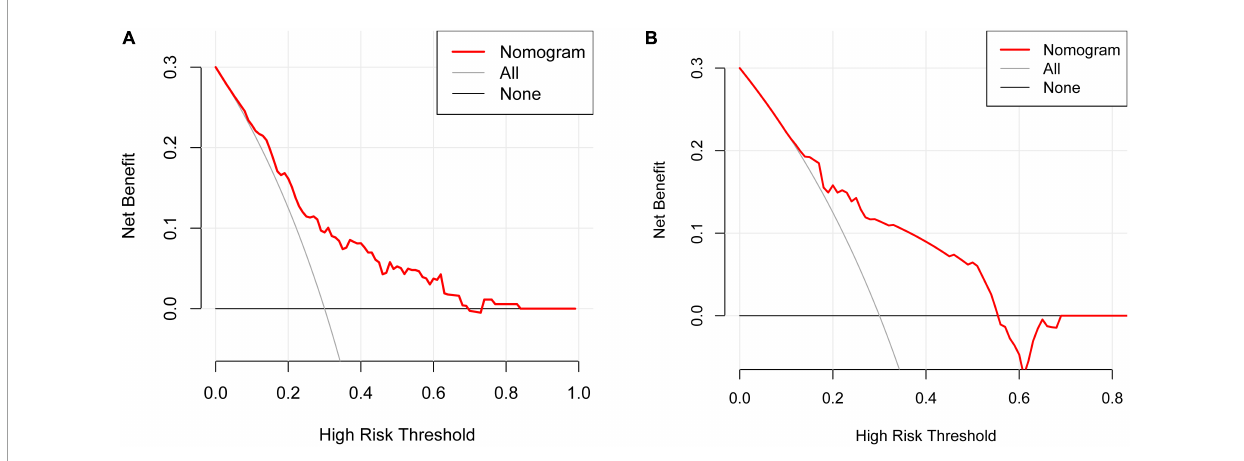
FIGURE6 Decision curve analysis (DCA) for the limb weakness risk nomogram. The thick solid line indicated the assumption that no limb weakness existed in any of the patients. The thin solid line denoted the idea that all patients suffered from limb weakness. The risk nomogram was represented by the red line. (A) The training set. (B) The validation